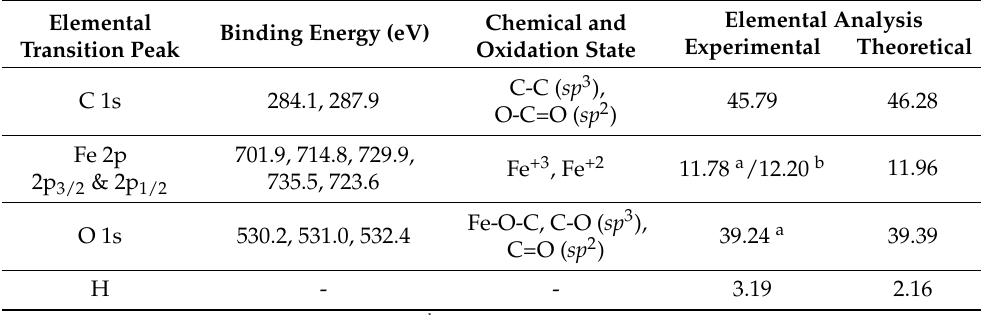
Table 1. XPS survey analysis and elemental compositions and binding energies of Fe(III)-TA. Elemental Analysis Elemental Chemical and Binding Energy (eV) Experimental Transition Peak Oxidation State